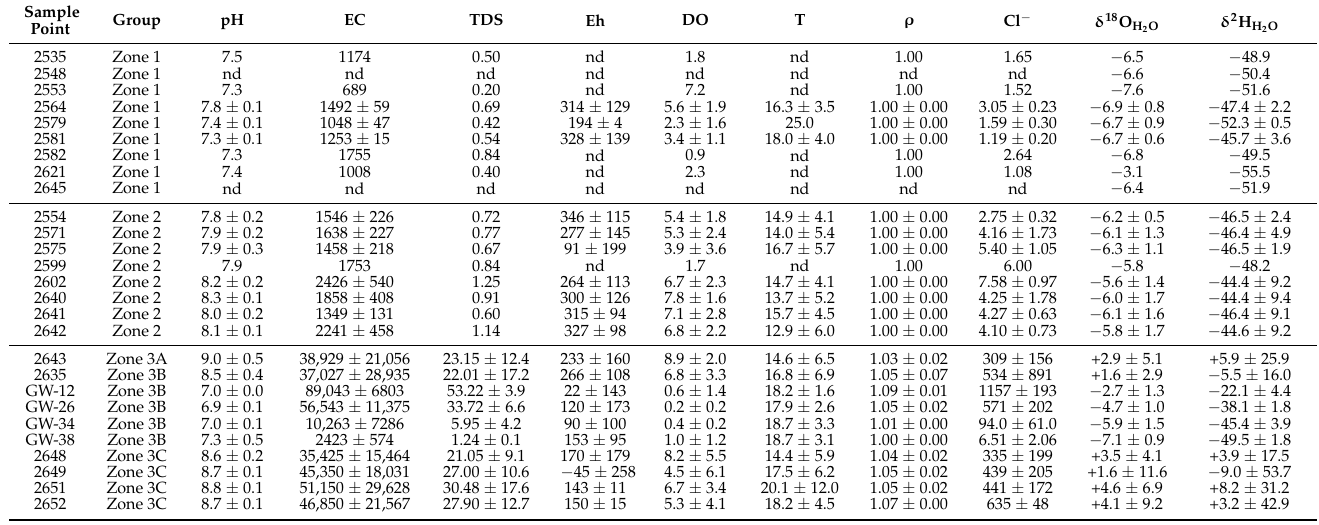
(Figure 3). Those water samples had the lowest EC values, varying between 689 µ S/cm (control point 2553) and 1755 µ S/cm (control point 2582). The density values were con- stant, with a value of 1.00 g/cm 3 ( n = 16). The chloride concentrations oscillated from 0.96 mmol/kg in control point 2581 to 3.32 mg/L in control point 2564, with an average value of 2.10 mmol/kg ( n = 16). The values of δ 18 O H in Zone 1 varied from − 8.0‰ 2 O (in 2579) to − 3.1‰ (in 2621), with a mean value of − 6.6‰ ( n = 22). The δ 2 H H data 2 O varied between − 55.5‰ (in 2621) and − 39.8‰ (in 2581), showing a mean value of − 49.0‰ ( n = 22). The water samples from Zone 2 showed hydrofacies similar to those in Zone 1, varying between Mg-Ca-SO 4 -HCO 3 and Na-Ca-HCO 3 -Cl (8 control points, n = 90) (Figure 3). Zone 2 provided higher EC values than the samples from Zone 1, which varied from 1060 µ S/cm in control point 2640 to 3200 µ S/cm in control point 2602. The density values were also stable (1.00 g/cm 3 , n = 90). The chloride concentration varied between 2.38 mmol/kg (in 2554) and 10.2 mmol/kg (in 2640), with a mean value of 4.46 mmol/kg ( n = 90). The δ 18 O H values ranged from − 8.7‰ (in 2640) to − 0.7‰ (also found in 2640), 2 O with an average value of − 6.0‰ ( n = 93), whereas the values of δ 2 H H ranged from 2 O − 52.4‰ (in 2641) to − 12.8‰ (in 2640), with an average value of − 45.7‰ ( n = 94). Table 1. Mean values of the chemical and isotopic analyses in water samples. EC: electrical con- ductivity ( µ S/cm). TDS: total dissolved solids (g/L). Eh: redox potential (mV). DO: dissolved oxygen (mg/L). T: temperature ( ◦ C). ρ : density (g/cm 3 ). Cl − expressed in mmol/kg. Isotope values expressed in ‰. Nd: not determined.